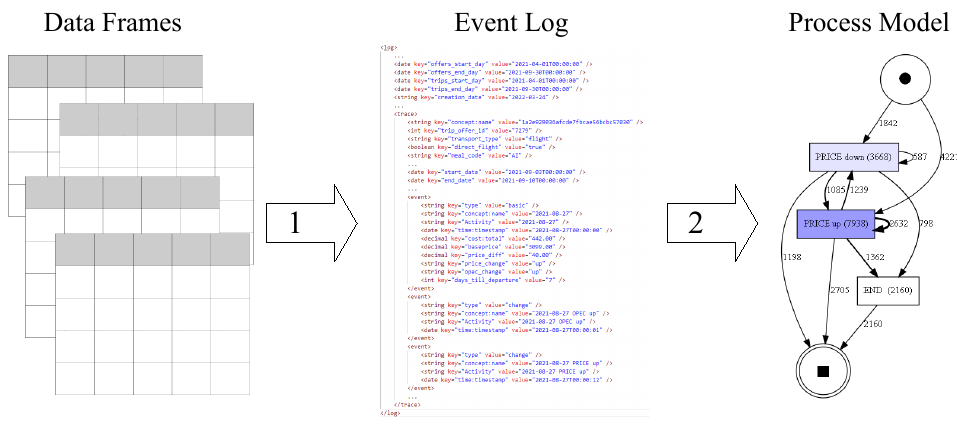
Figure 12. Steps to convert the Data Frames into a process